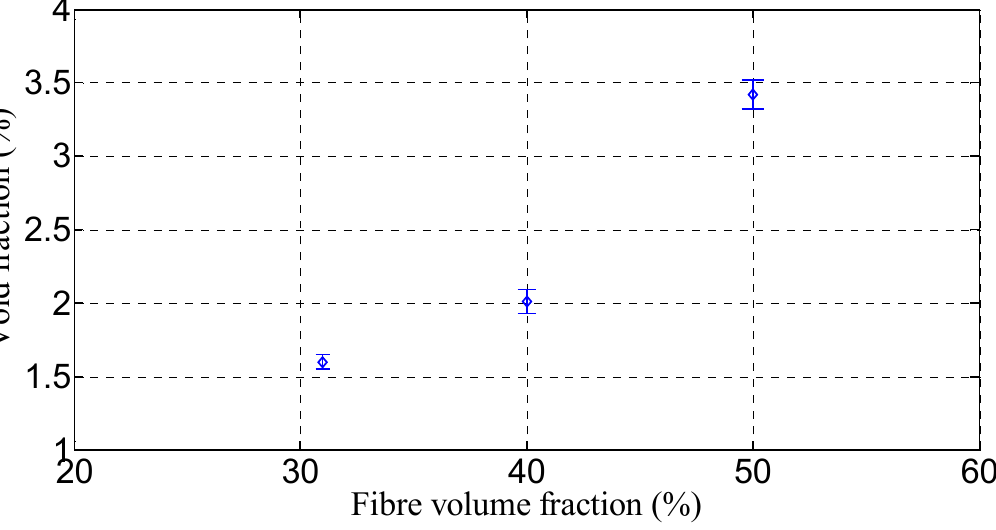
Figure 10. Void content of flax/PP composites.